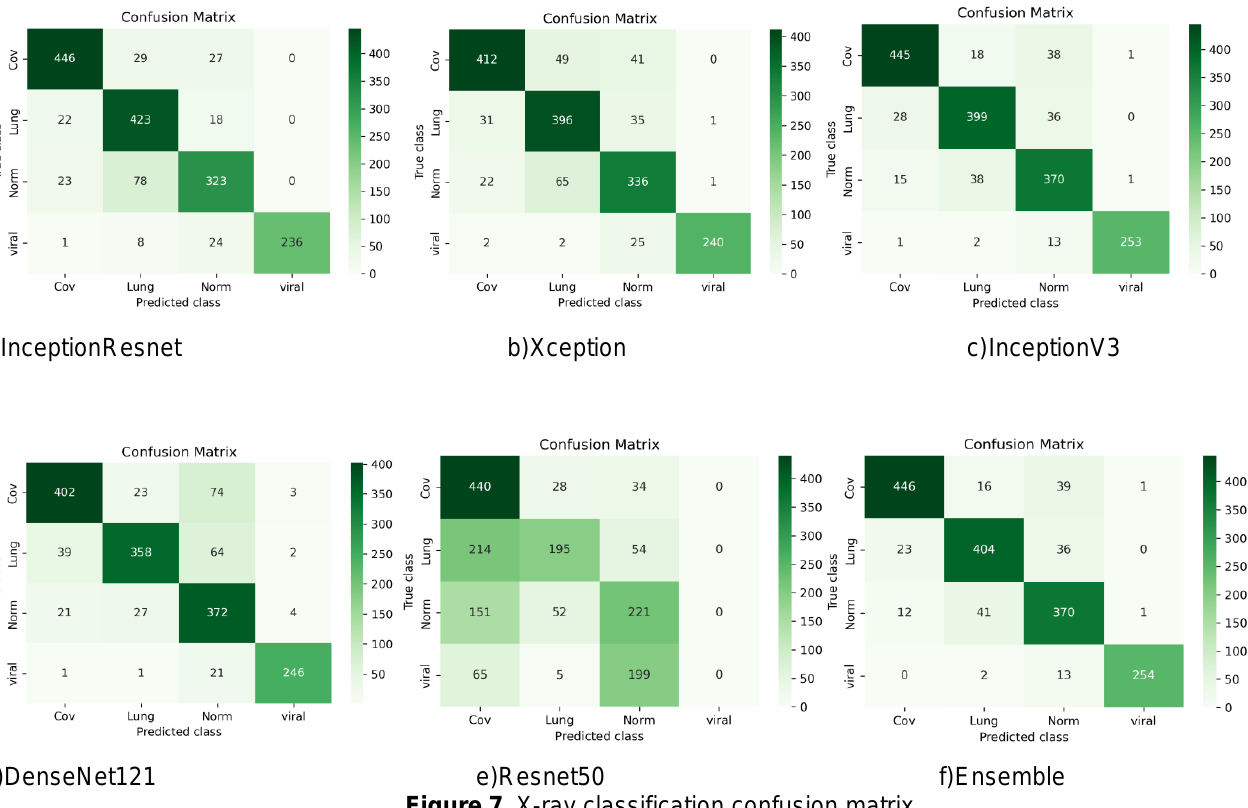
Figure 7. X-ray classification confusion matrix